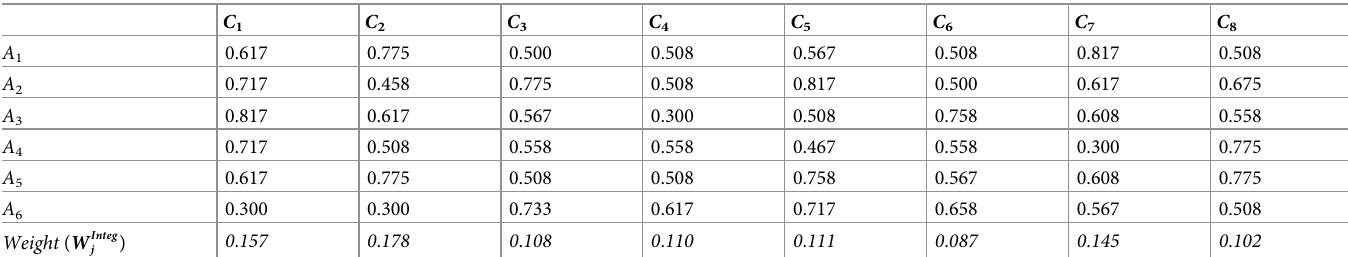
Table 11. Aggregated defuzzified ratings of alternatives.